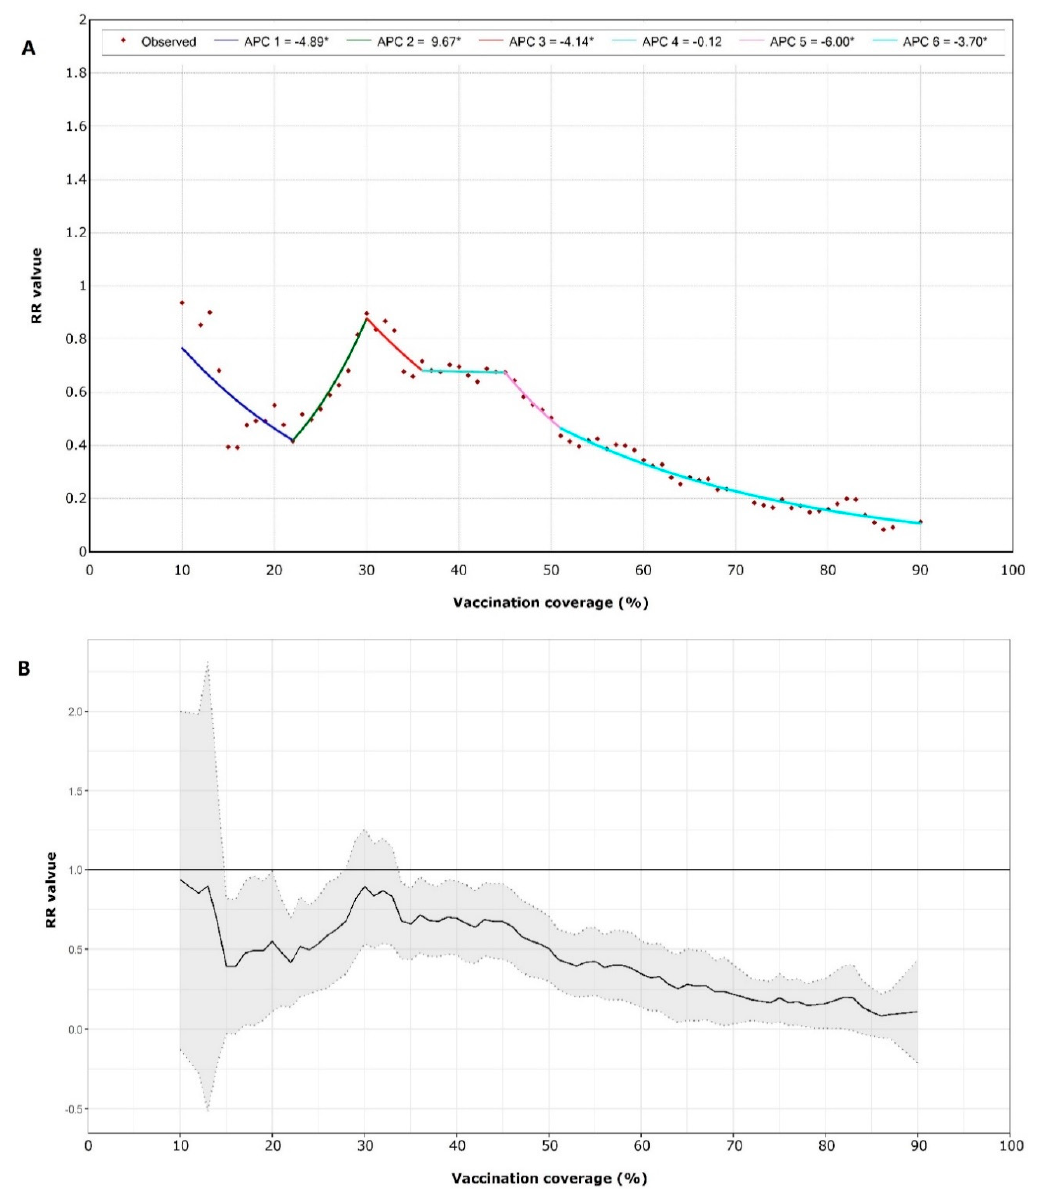
Figure 2. ( A ) Joinpoint model of relative risk (RR) values for different vaccination coverage. There are five joinpoints for the model. The symbol * is shown if the annual percent change (APC) is significantly different from zero at level 0.05. ( B ) RR values for vaccination coverage from 10% to 90% with 95% confidence